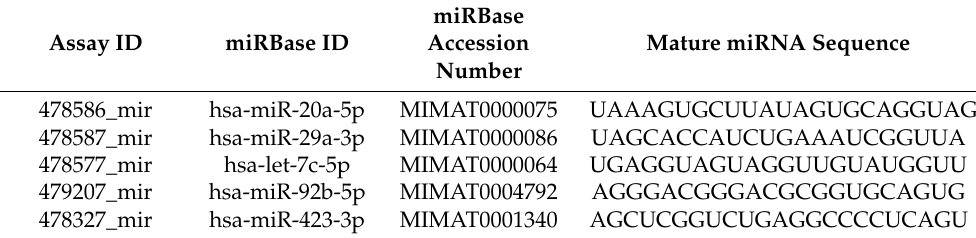
Table 2. List of TaqMan assays for miRNA